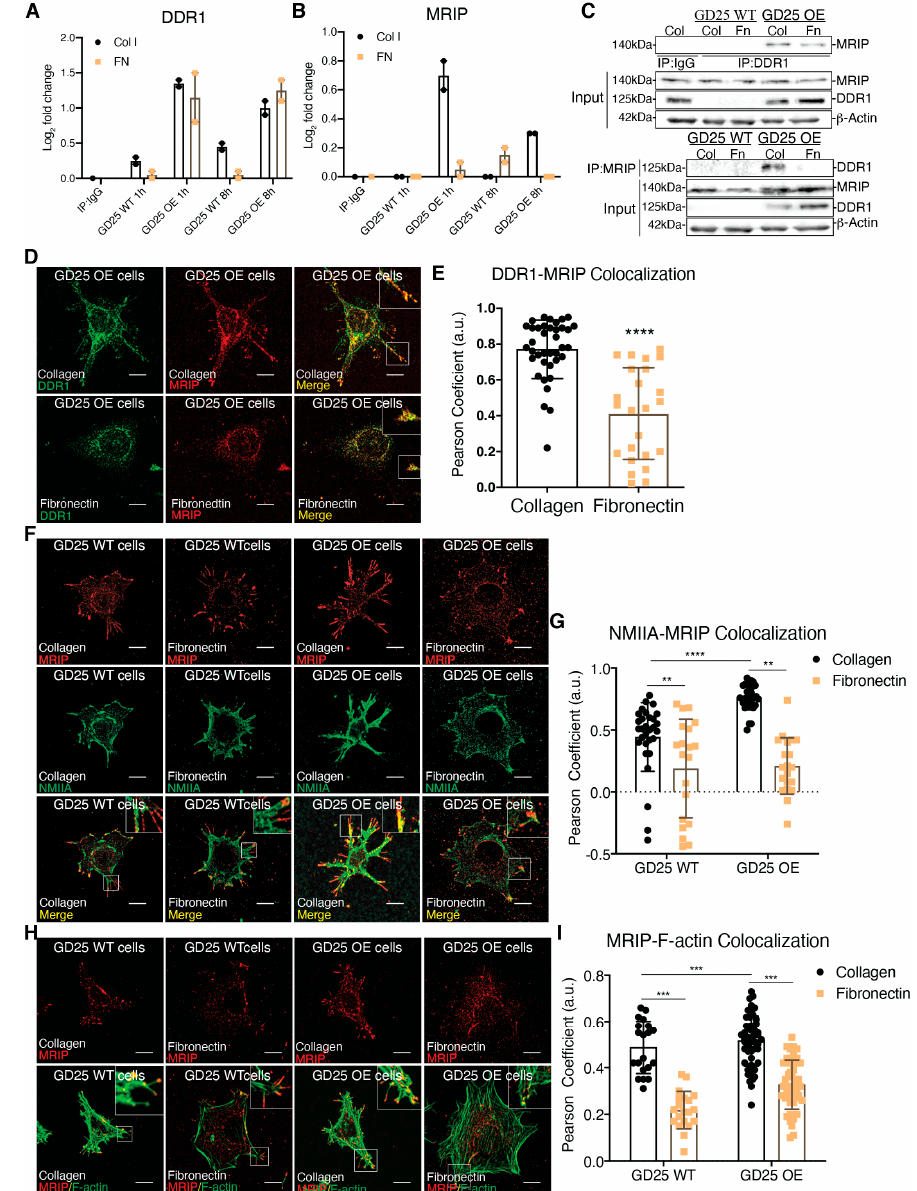
Figure 1. MRIP is enriched DDR1 collagen adhesion complexes. ( A , B ) DDR1 (C-20: sc-532) was immunoprecipitated from cell lysates of GD25 WT and GD25 OE cells cultured on collagen or fibronectin for 1 or 8 h. Immunoglobulin G (IgG, ab37415) was immunoprecipitated from cell lysates of GD25 OE cells cultured on collagen for 8 h and used as control. Immunoprecipitates were processed and analyzed by liquid chromatography - tandem mass spectrometry (LC-MS / MS). Plot represents the relative abundance of DDR1 (A) and MRIP (B) in each immunoprecipitate, n = 2. ( C ) IgG, DDR1 (C-6: sc-374618), and MRIP (D8G8R, CS), were immunoprecipitated from cell lysates of cells cultured on fibrillar collagen or fibronectin. The immunoprecipitates were immunoblotted for DDR1 and MRIP. Whole-cell lysates were immunoblotted for β -actin as loading control. ( D , F , H ) Indicated cells were cultured on collagen or on fibronectin for 3 h and co-immunostained for MRIP (C-14: sc-135494, red) and DDR1 (C-6: sc-374618, green), for MRIP and NMIIA (2B3, ab55456, green), and for MRIP and F-actin (green). ( E , G , I ) Pearson coe ffi cients were obtained by quantification of the fluorescent images using the colocalization2 plug-in in Fiji. Data are reported as mean ± SD, n = 3, at least 20 cells per group in E, G, and I. ** p < 0.005, *** p < 0.0005, **** p < 0.0001. Scale bar, 10 µ